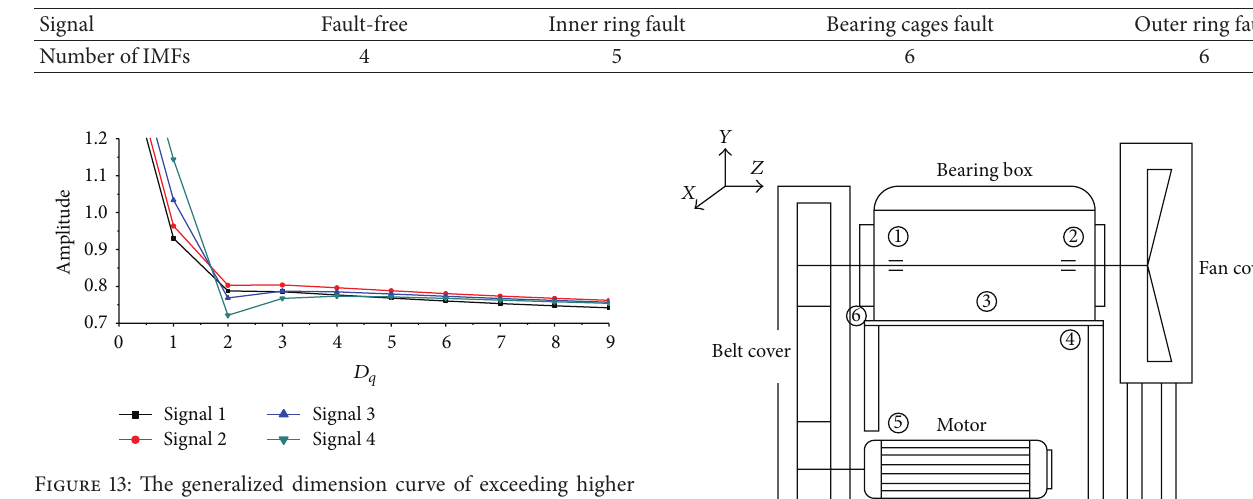
Table 6: The results of EMD.